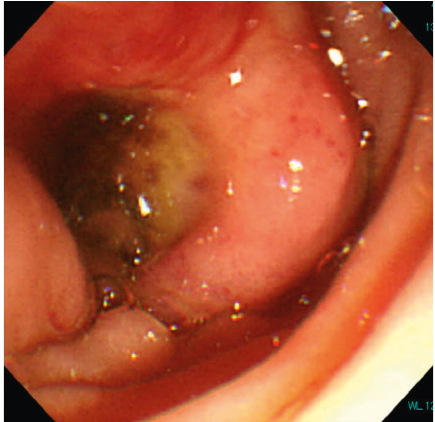
Figure 2: Endoscopic findings. Endoscopy revealed an ulcer and bulging of the thickened duodenal wall (second to third portion), where the perforation